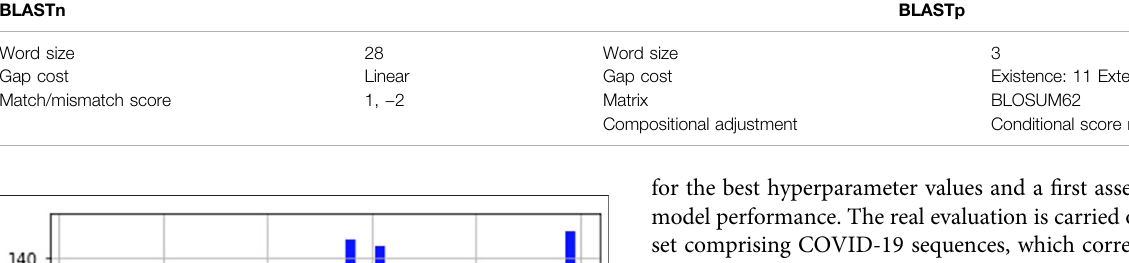
TABLE 1 | Parameters used in BLASTn and BLASTp in the alignment of the coronavirus genomes and proteins. BLASTn